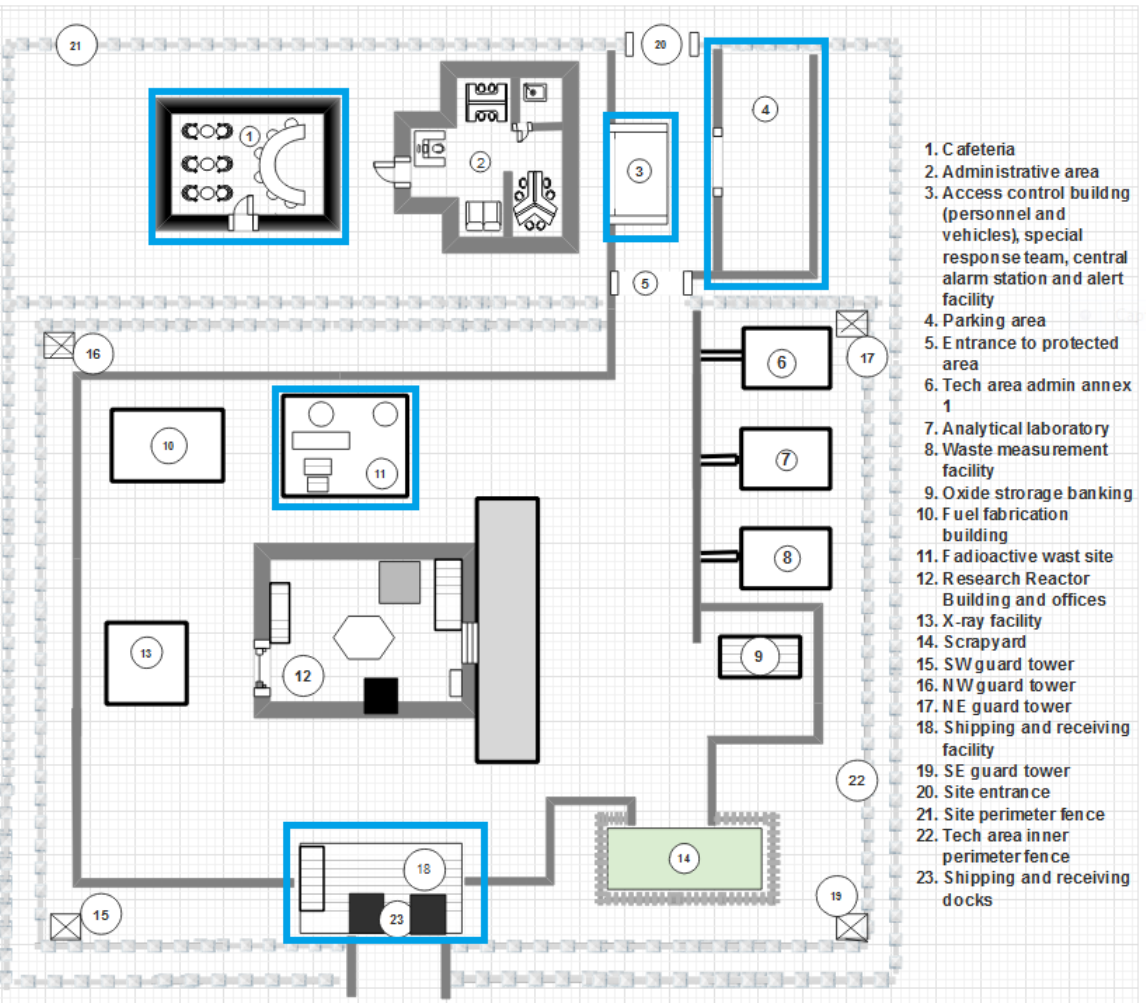
Figure 2: The New Site